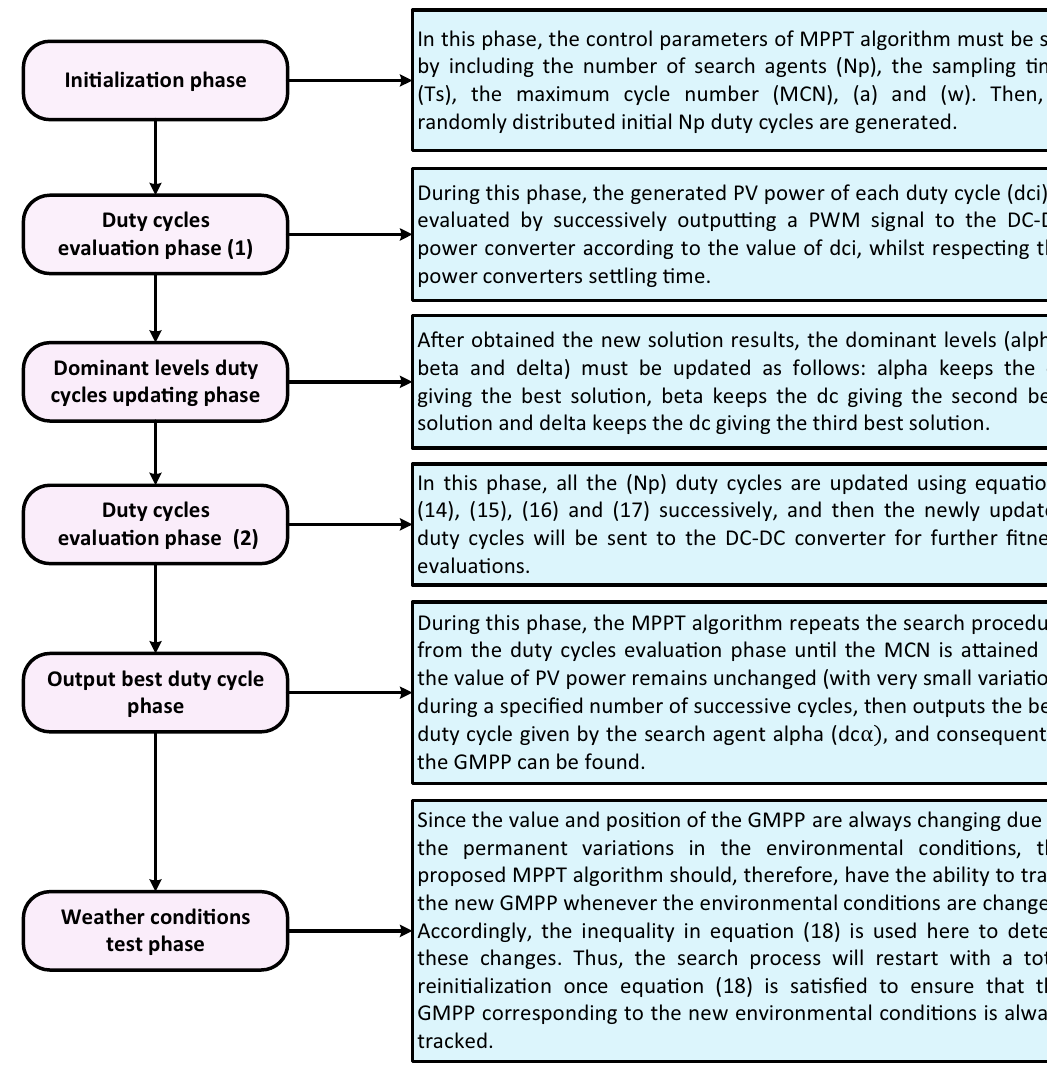
Figure 5. Application procedure of the proposed GWO–PSO based